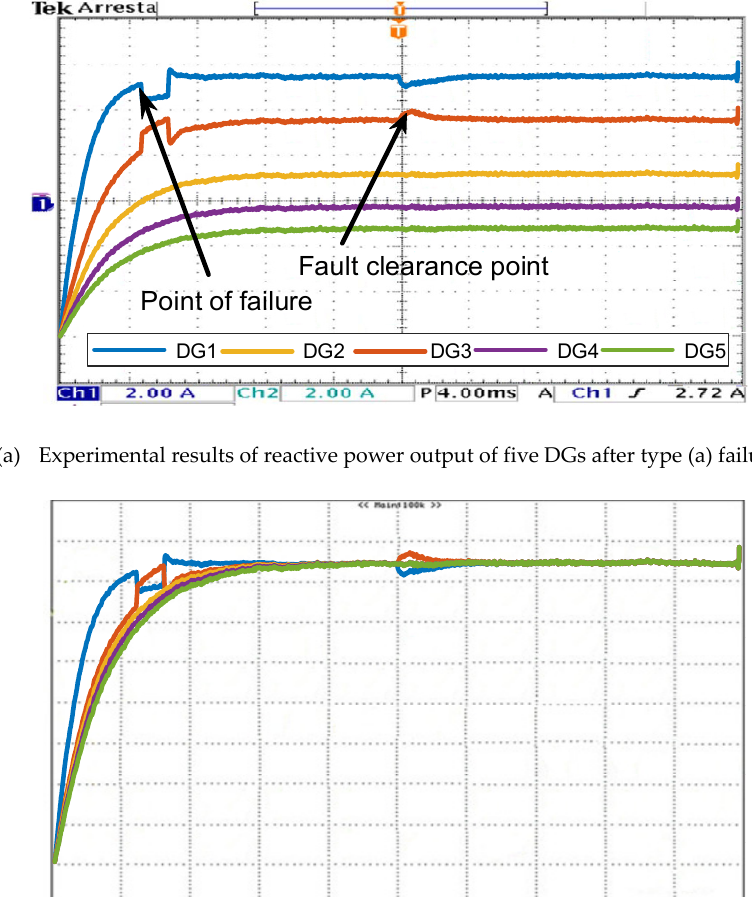
Figure 20. Communication networks and three types of failures of five DGs in the experiment.